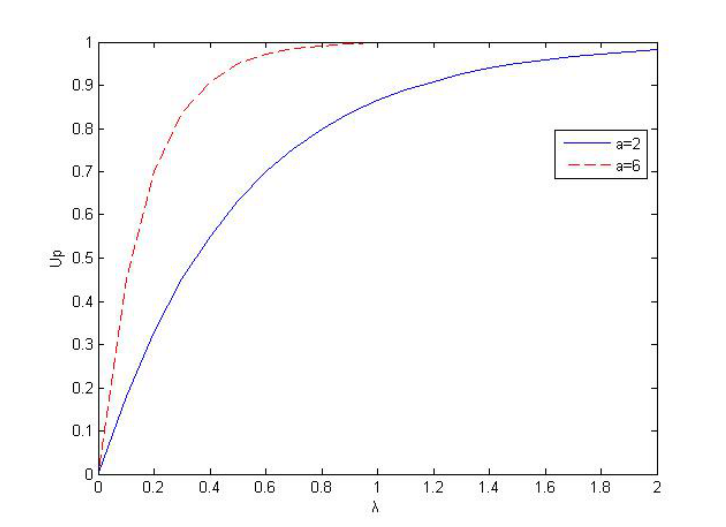
Figure 3. The satisfactory function of primary users U d versus λ